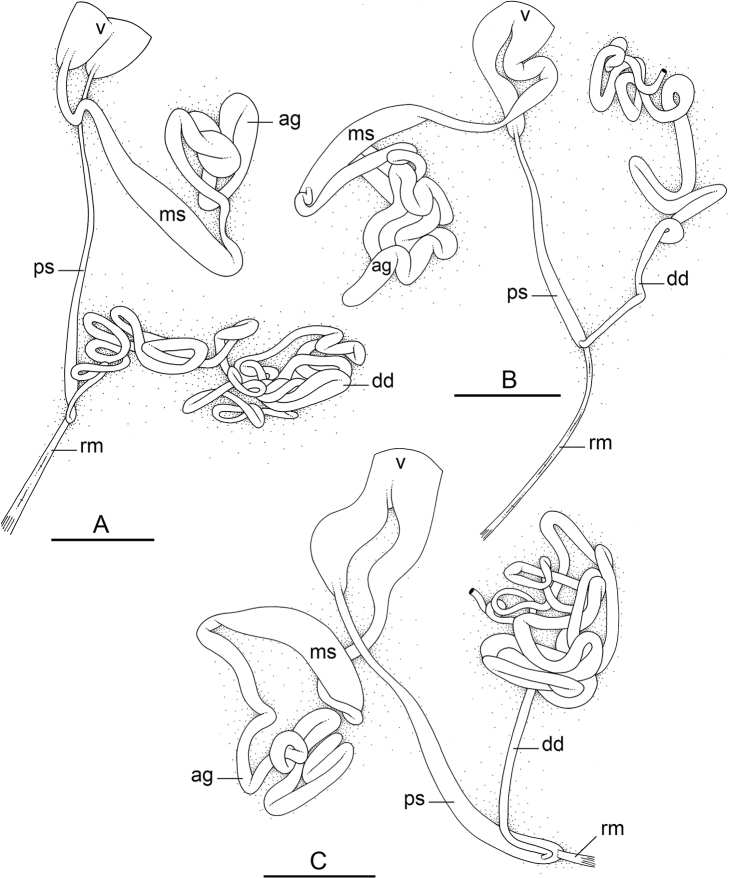
Anterior, male, copulatory apparatus, Peronia
plateiA lectotype, French Polynesia, Moorea (SMNH-Type-7537) B Papua New Guinea, Madang [5412] (MNHN-IM-2013-13351) C Hawaii [706] (UF 303653). Scale bars: 5 mm (A), 3 mm (B), 2 mm (C). Abbreviations: ag accessory penial gland, dd deferent duct, ms muscular sac, ps penial sheath, rm retractor muscle, v vestibule.